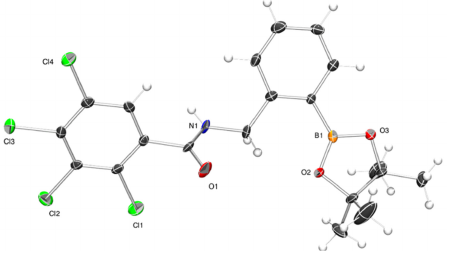
Figure 2. ORTEP plot of compound meta 5 (30% ellipsoids). In the structure of ortho 8 (Figure 3) , the substituents on the B-substituted ring are in ortho positions. In comparison with meta 5 , the insertion of a methylene group between the amide and B-substituted phenyl ring relieves torsional strain (C Ar -C Ar -C(H 2 )-N1 4.6°). The other structural features resemble those found in meta 5, defined by the dihedral an- gles O1-C-N1-H 173.8° and C Ar -C Ar -C-O1 76.6°, C Ar -C-N1a-C 61.1°.